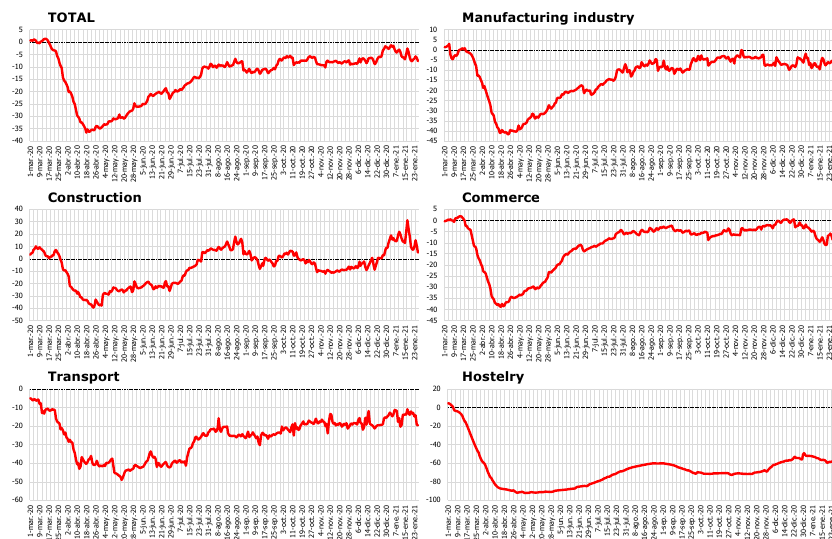
Fig. 9 Final corrected series (MA28 levels): Year-on-year (YoY) growth rate